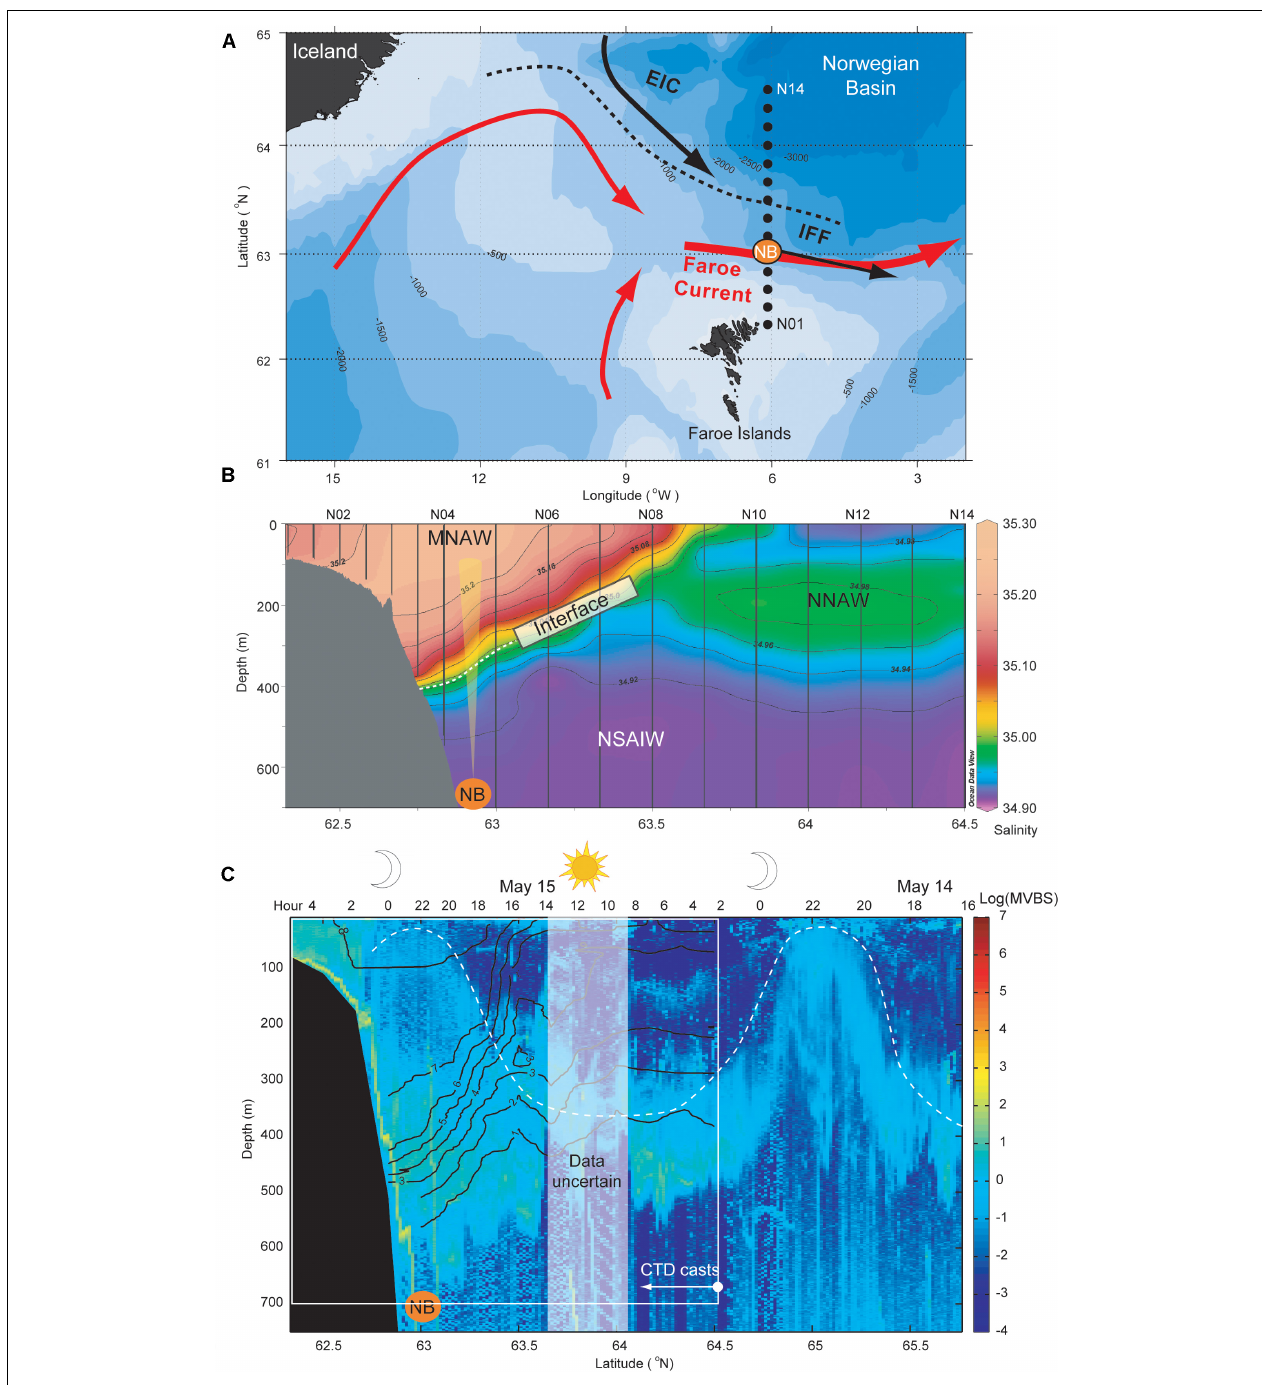
FIGURE 1 | (A) Bathymetry and circulation of the study area. Standard hydrographic stations are illustrated as black dots along Section N (06.08 ◦ W). EIC, East Icelandic Current; IFF, Iceland-Faroe Front. The position of ADCP mooring NB is here (and in the panels below) illustrated as an orange dot, and the average observed current direction is shown with the black arrow. (B) Average salinity along Section N based on CTD (Conductivity, Temperature, Depth) observation by R/V Magnus Heinason in the period June 2013 to May 2015, and the position of the main interface separating warm Atlantic waters from colder underlying waters is emphasized. The figure is plotted using Ocean Data View (Schlitzer, Reiner, Ocean Data View, https://odv.awi.de, 2020). (C) acoustic transect along an extended Section N during May 14–15, 2018. Data obtained from the ship-mounted echo-sounder on-board R/V Magnus Heinason, are here provided as the mean value backscattering strength (MVBS) over 1 m depth intervals and 10 min “distance” (the ship cruises at about 10 knots) intervals. The values are furthermore log-transformed, in order to emphasize the diffuse small biota, which are focus of the present study. The position of the 1–8 ◦ C isotherms, obtained from concurrent CTD casts are overlaid with black lines, and the diel vertically migrating layer is emphasized with a white dashed curve. Duration of day and night are illustrated at the top of the subfigure, and the white rectangle in (C) outlines the coverage of panel (B) . MNAW, Modified North Atlantic Water; NNAW, Norwegian North Atlantic Water; NSAIW, Norwegian Sea Arctic Intermediate